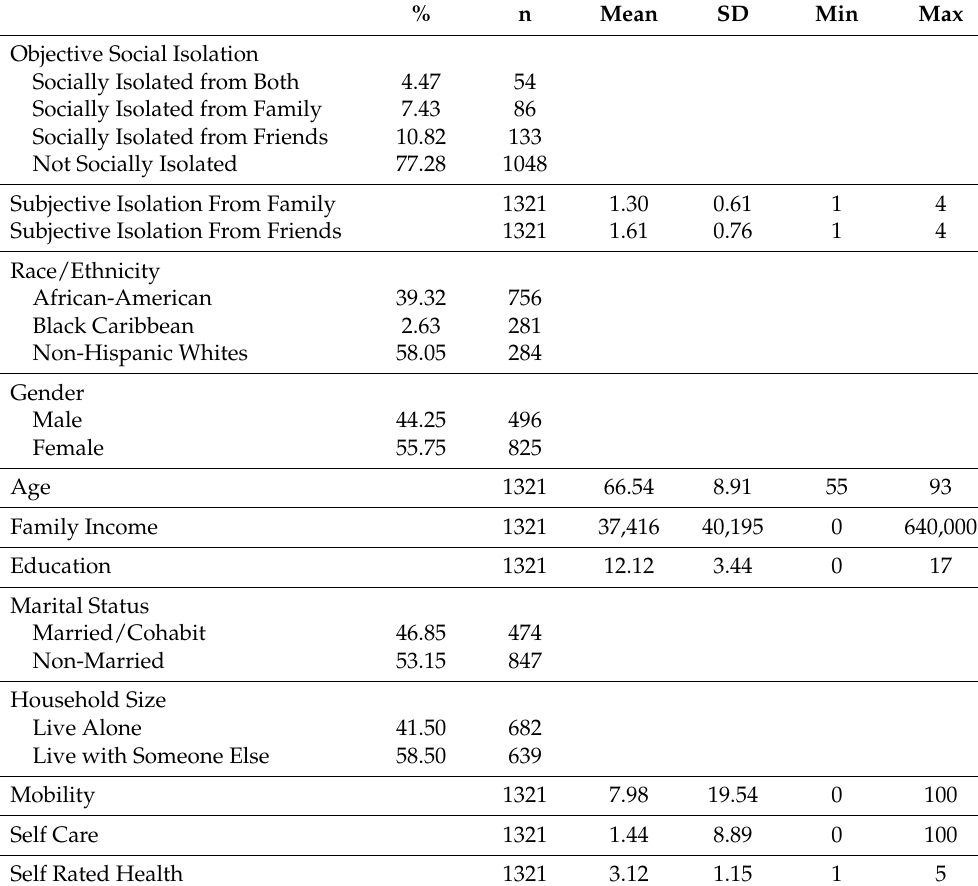
Table 1. Demographic Characteristics of the Sample and Distribution of Study